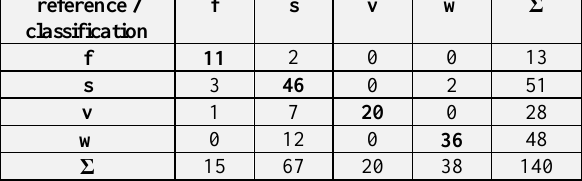
Figure 5. Decision tree derived from training areas. The nodes are thresholds of the class attributes (dZ=height above ground [m], Srgb=sum of intensities in three colour bands, Pndvi= normalized difference index). The end nodes of the tree are depicted with the names of the classes (“window”=f, “vegetation”=v, “stonework”=s, “painted wall”=w).